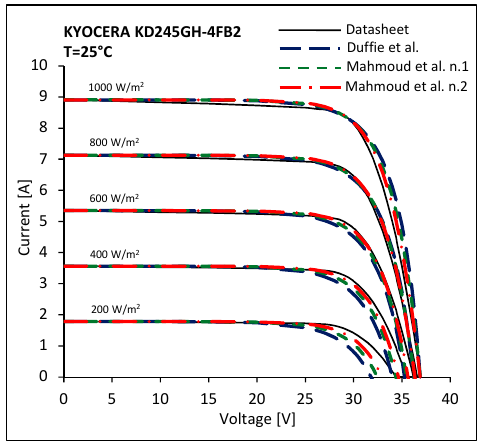
Figure 7. Comparison between the issued I-V characteristics of the Kyocera KD245GH-4FB2 at T = 25 °C and the characteristics calculated by means of the Duffie et al. and the Mahmoud et al. models.